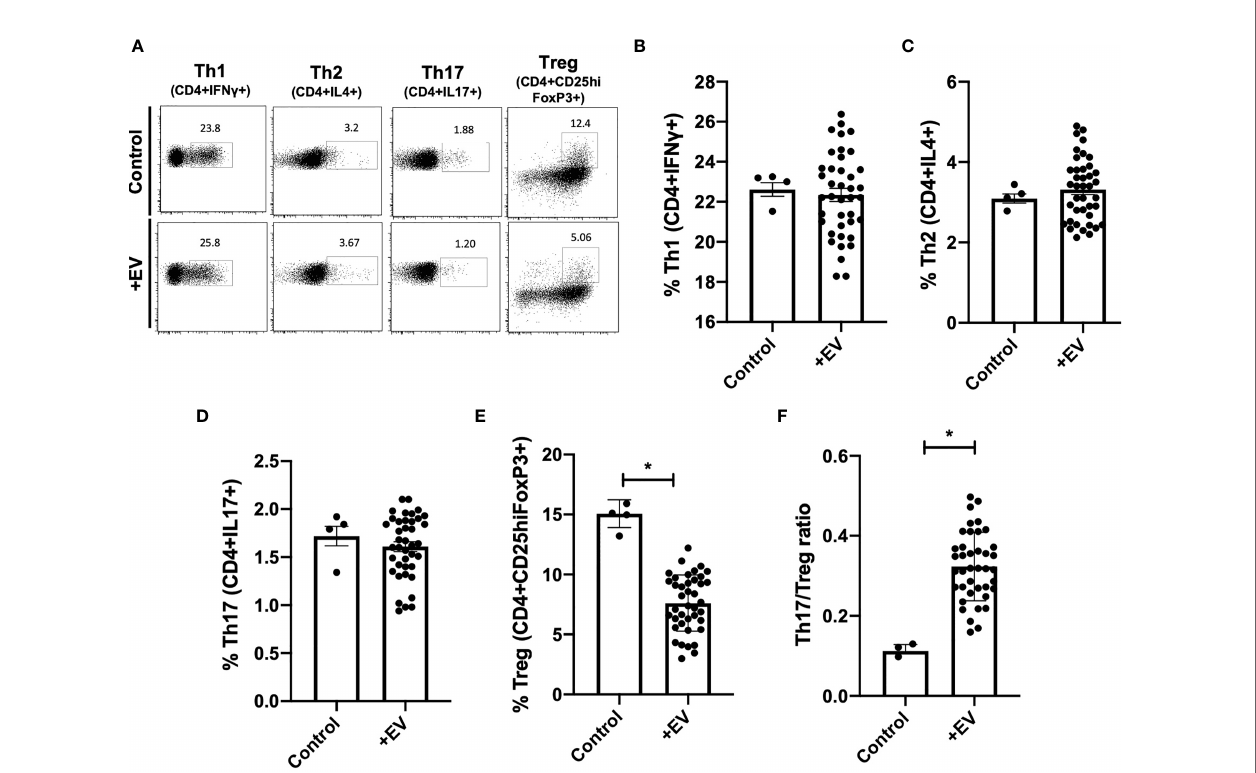
FIGURE 3 | KP-EV increase Th17/Treg ratios in PBMCs. (A – F) For T cell activation assays, PBMC were stimulated with 1 m g/mL of anti-CD3 mAb (OKT3) and 2 m g/mL of anti-CD28 mAb; PBMC from HC (n=4) were seeded with KP-EV (n=10). On day 7, cells were stained for CD4, CD25, IFN g , IL4, IL17 and FoxP3. (A) Representative fl ow cytometry plots and percentages of subpopulations of (B) Th1 (CD4 + IFN g + ), (C) Th2 (CD4 + IL4 + ), (D) Th17 (CD4 + IL17 + ), (E) Treg (CD4 + CD25 hi FoxP3 + ) and (F) the ratio of Th17 to Treg. Each data point represents a KP-EV (n=10) or control EV exposed to HC PBMC (n=4) (technical duplicates). *represents p- values ≤